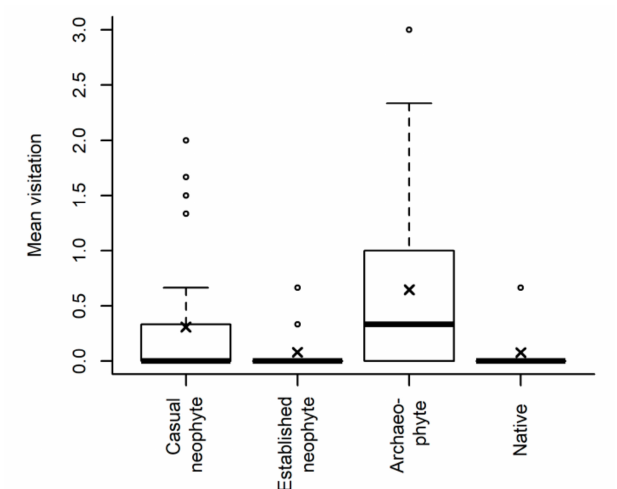
Figure 1. Number of flower visitors (mean of three days of observation) depending on invasion status (for 31 species and 100 individuals that had flowers open at the time of flower visitor observation). The boxplots show the median per group (solid line), crosses the mean, the boxes represent the 25th and 75th quantile, whiskers the normal data range and circles the outliers.